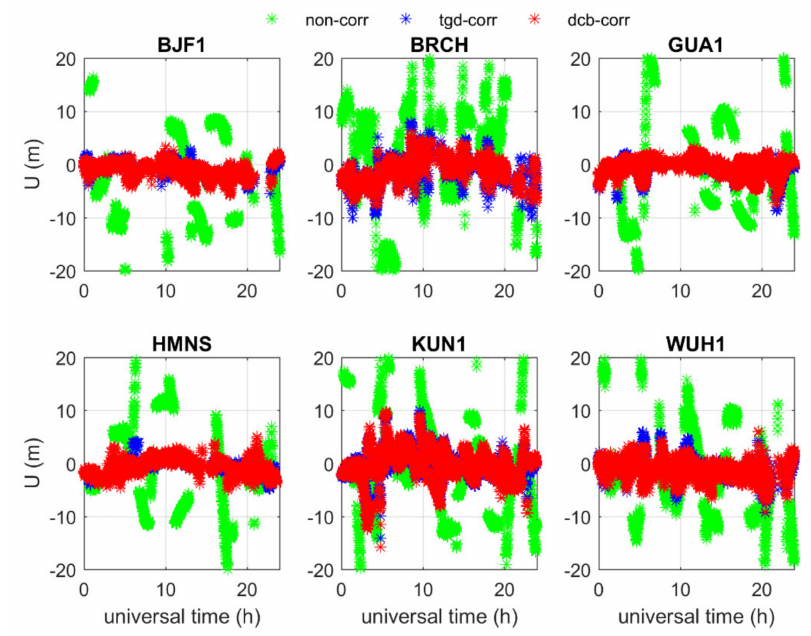
Figure 6. Vertical positioning error scatters with and without TGD or DCB correction of B1I SPP at six